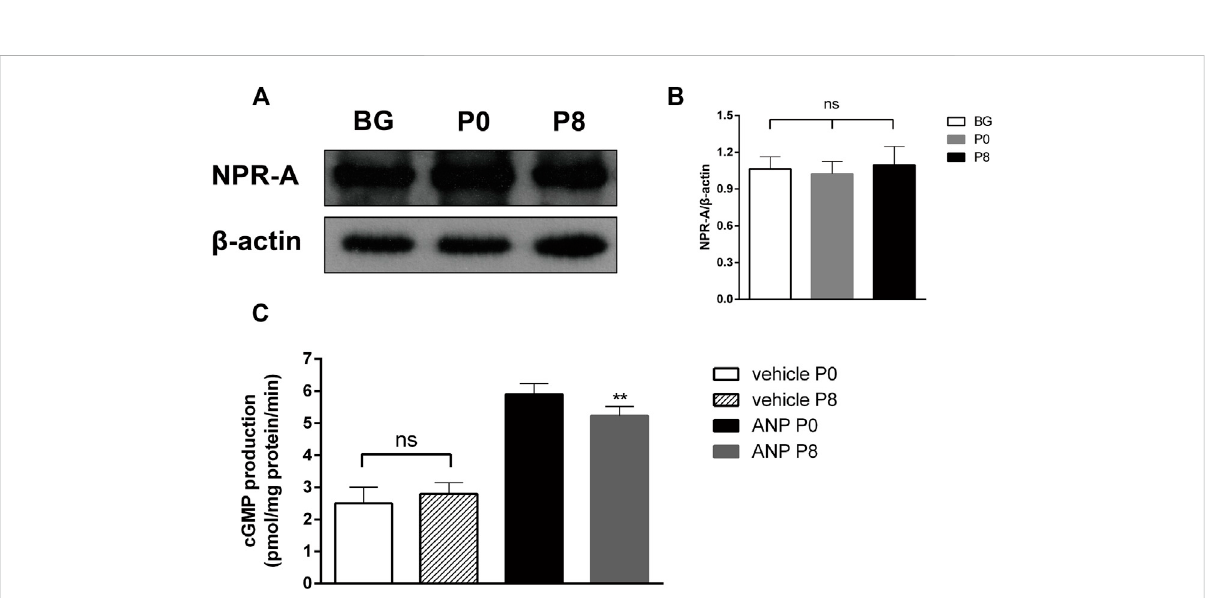
FIGURE 5 Effects of rapid pacing on NPR-A and PGC activity inthe rabbit atrium. (A) NPR-A proteinlevel after rapid pacing stimulation for 8 h (BG= Black group). (B) Quantitative analysis of NPR-A protein levels, p > 0.05. (C) cGMP production in the atrial membrane (PGC activity), ** p < 0.01 vs. ANP P0. Data are expressed as mean ± SEMs, n =